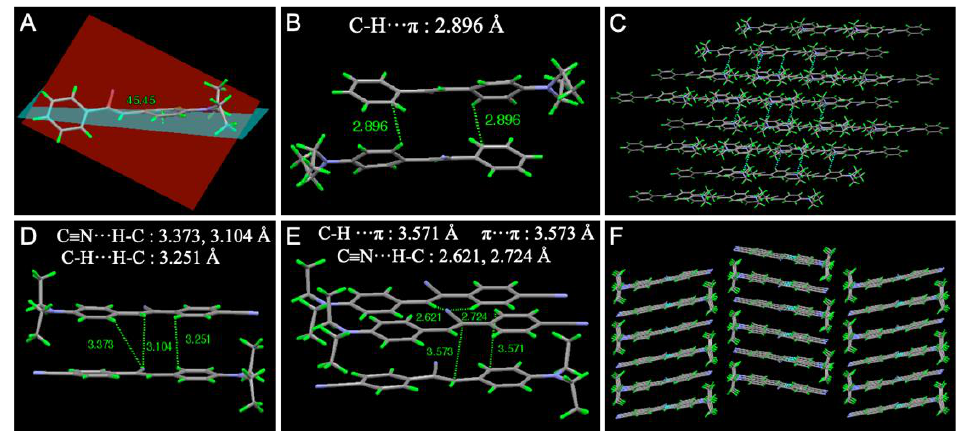
Figure 5. The crystal structures and intermolecular interactions of ( A – C ) 1 and ( D , F ) 2. Hydrogen: Green, Carbon: Grey, Nitrogen: Purple.